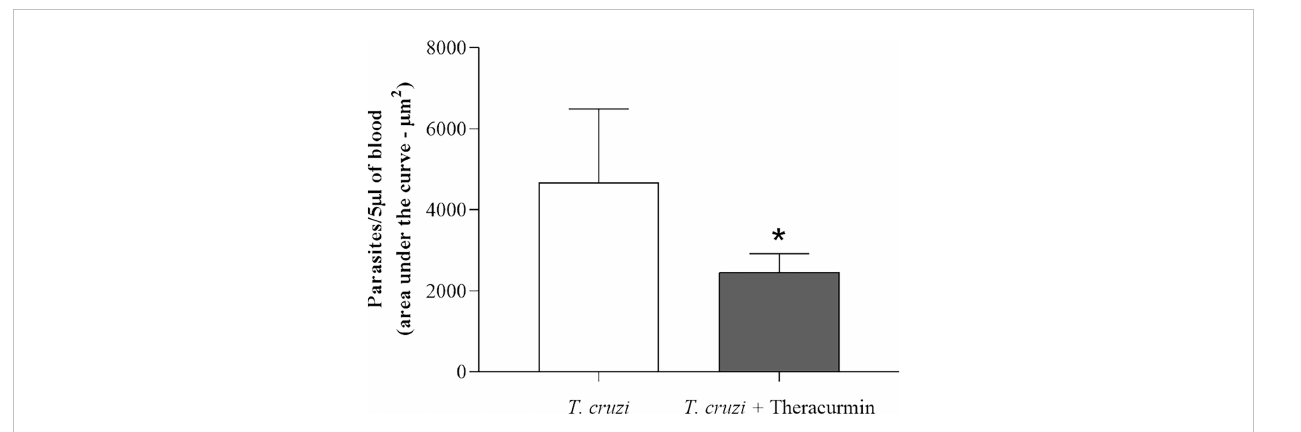
FIGURE 1 Area under the curve of the parasitemia of the T. cruzi infected group (n=7) and the T. cruzi + Theracurmin group (n=7). Data are expressed as mean ± SE. * shows signi fi cant difference (p =